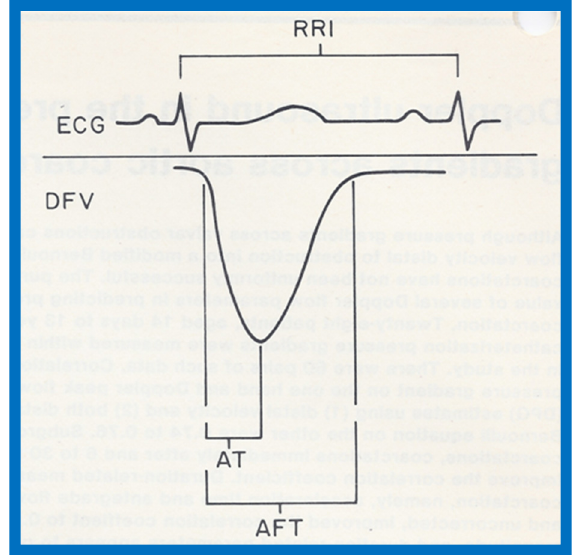
Figure 55. Line drawing of the Doppler flow velocity curve sampled from the descending aorta distal to coarctation site from a suprasternal notch view demonstrating measurement of duration ‐ related parameters. AFT: antegrade flow time; AT: acceleration time; ECG: electrocardiogram; DFV: Doppler flow velocity curve; RRI: R ‐ R interval of the ECG. Reproduced from Rao P.S., Carey P. [18]. A comparison of the Doppler ‐ derived ( ∆ P = 4V 2 ) peak instantaneous and catheterization ‐ measured peak ‐ to ‐ peak gradients resulted in a correlation coefficient of 0.757. (Figure 56A). The inclusion of both proximal and distal velocities ( ∆ P = 4[V 22 − V 12 ]) in the modified Bernoulli equation (Figure 56B) did not significantly increase the correlation ( r = 0.763). A comparison of the catheterization data with antegrade flow time ( r = 0.82) and antegrade flow time fraction ( r = 0.737) showed marginal, if any, improvement in the correlation coefficients (Figure 56C,D). Separating into subgroups of native, immediate postballoon and follow ‐ up postballoon did not improve the correlation coefficients (Tables II and III from [18]). However, a blend of magnitude and duration related Doppler curves (using the method of “All Possible Subsets Regression”; Catheterization gradient = 0.31DPV + 0.22 AFT fraction + 0.04 AFT − 16.67) [18] improved the correlation coefficient to 0.92 (Figure 57). It was also observed that peak gradients in excess of 25 mmHg were seen in the presence of pandiastolic flow in the descending aortic Doppler curve with 100% specificity and 80% sensitivity (Figure 58).